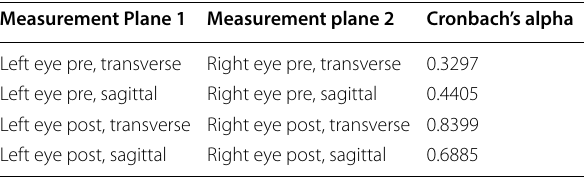
Table 7 Agreement of measurements between eyes (right vs left) for each plane, pre- and post-lumbar puncture Measurement Plane 1 Measurement plane